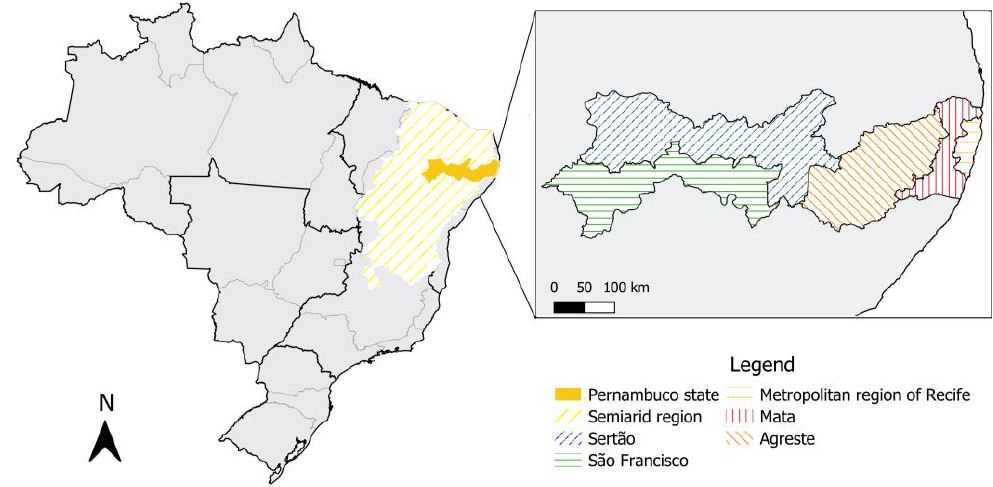
Figure 1. Location of the Agreste region of the state of Pernambuco, the study area of the work. The study area comprises parts of the hydrographic basins of the Capibaribe, Ipojuca, Una, Mundaú, Ipanema and Moxotó rivers. In all, there are 35 municipalities and 6 vil- lages, 21 reservoirs and 5 pipelines, making up a universe of 41 consumption centers and 26 water sources. The possibility of allocating flows from different sources justifies the need for a DSS that facilitates the management of the region’s supply system. Figure 2 shows the hydrological network, the consumption centers and the infrastructure available for water supply in the region.